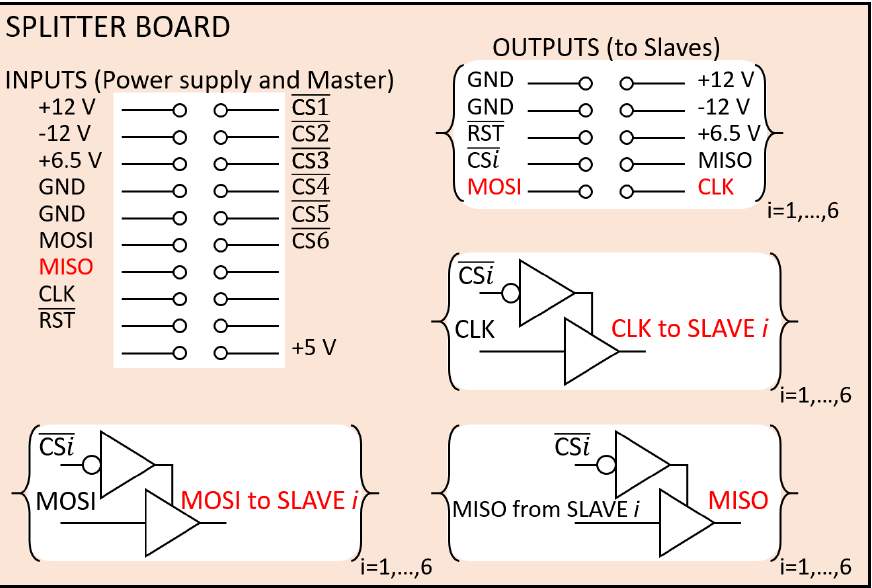
Figure 6. Simplified schematic of the splitter board with the bus drivers used to split SPI lines. The color red indicates buffered